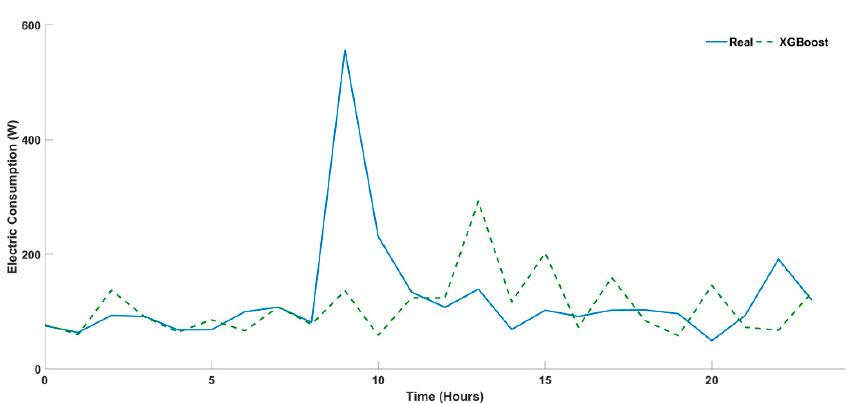
Figure 12. XGBOOST for 24-h ahead forecasting. Table 6. Results & ranking of the performance metrics.